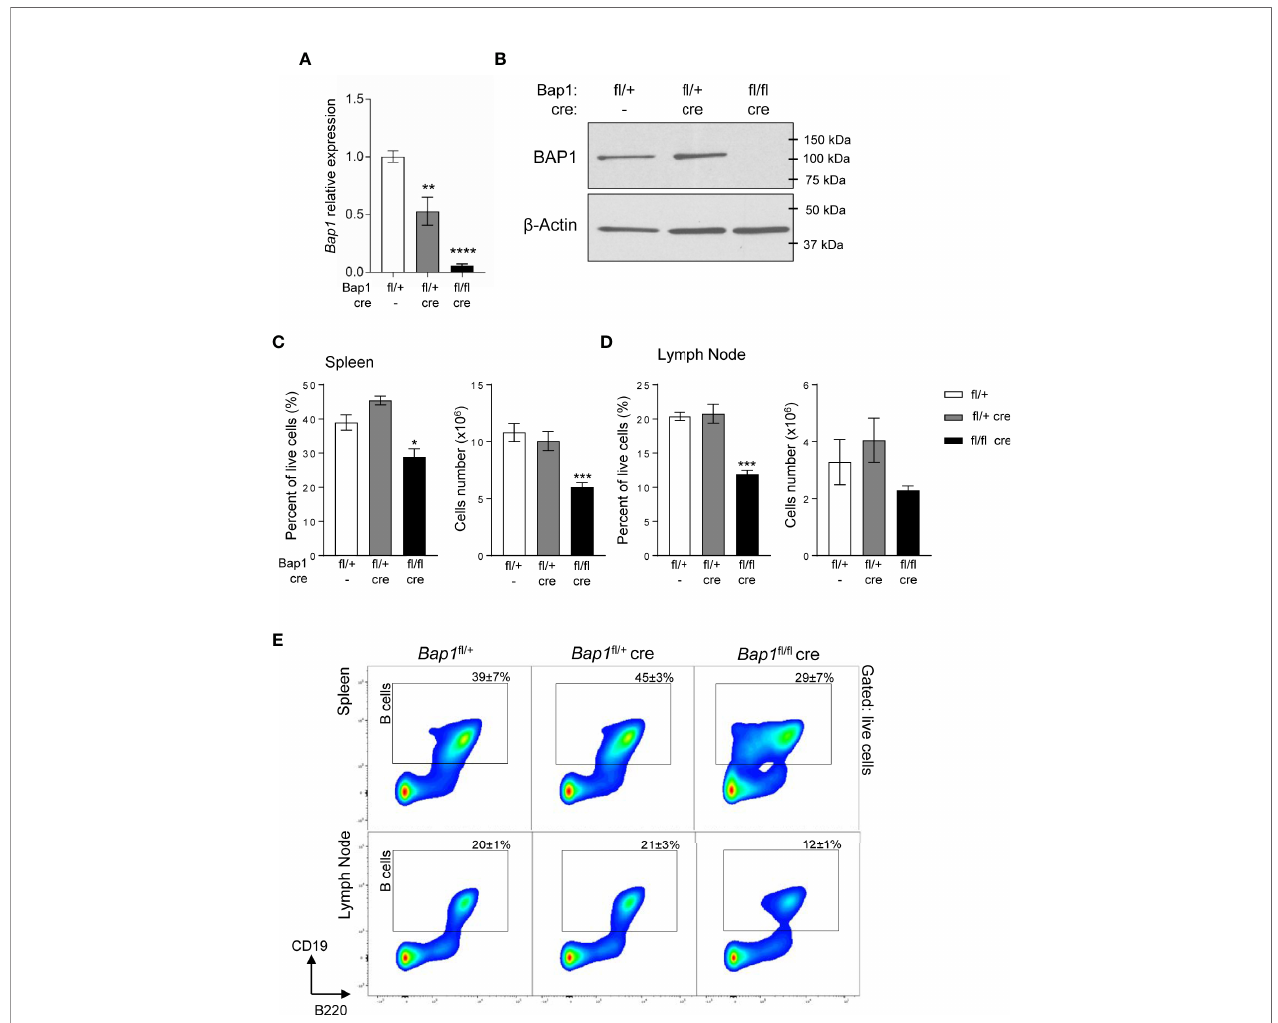
FIGURE 1 | Loss of BAP1 and depletion of B cells in the Bap1 fl / fl Cre mouse model. (A) Reduced Bap1 transcript levels in B cells magnetically isolated from the total splenocytes of Bap1 fl / fl Cre , relative to control mice, analyzed by RT-qPCR. Transcript levels are normalized to b -actin, and expressed relative to the transcript levels in control B cells. Data is from 4 mice per group; bars represent mean ± SEM; statistical analysis by ANOVA, **p < 0.01, ****p < 0.0001. (B) Loss of BAP1 protein in B cells magnetically isolated from the total splenocytes of Bap1 fl / fl Cre relative to control mice, analyzed by Western blotting, using b -actin as the loading control; data from one mouse per genotype. (C – D) Depletion of B cells in the spleen (C) and mesenteric lymph nodes (D) of Bap1 fl / fl Cre relative to control mice, expressed as the percentage of CD19 + cells within the total live cells from the tissue and as the absolute cell number. Data presented is from two experiments with 4 mice analyzed per group per experiment. Bars represent mean ± SEM; statistical analysis by ANOVA, NS non-signi fi cant, *p < 0.05, ***p < 0.001. (E) Representative fl ow cytometry density plots of the spleen (top) and mesenteric lymph nodes (bottom) stained for B cell lineage markers B220 and CD19, and gated on live cells. CD19 + B cell gate is shown and the percentage of cells within the gate for each mouse genotype is presented as mean ±